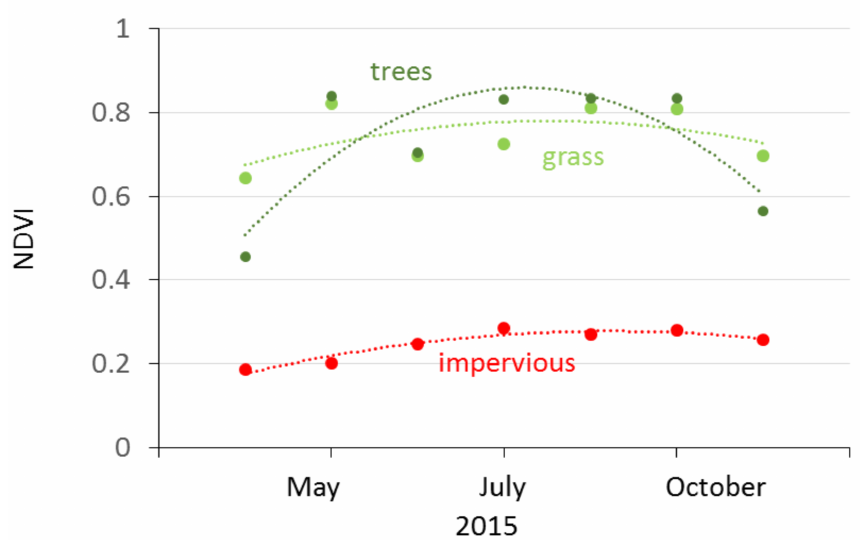
Figure 6. Seasonal dynamics of homogeneous Proba-V pixels from April to November